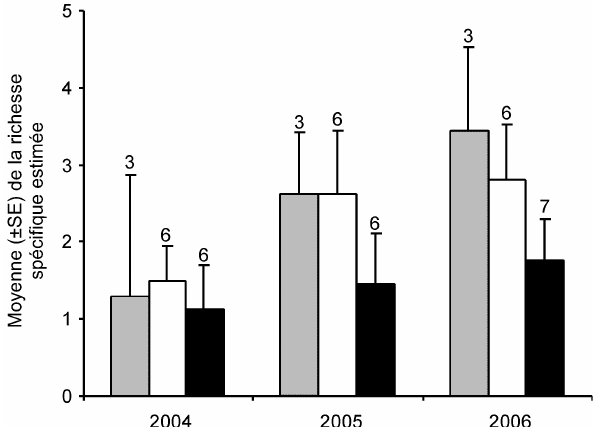
Fig. 1. – Variation de la moyenne de la richesse spécifique estimée en puces chez les tamias adultes au cours des trois périodes d’étude (gris : février-avril; blanc : mai-juillet; noir : août-novembre) en 2004, 2005 et 2006 en Forêt de Sénart. Le nombre de sessions bi-men- suelles est indiqué au-dessus des